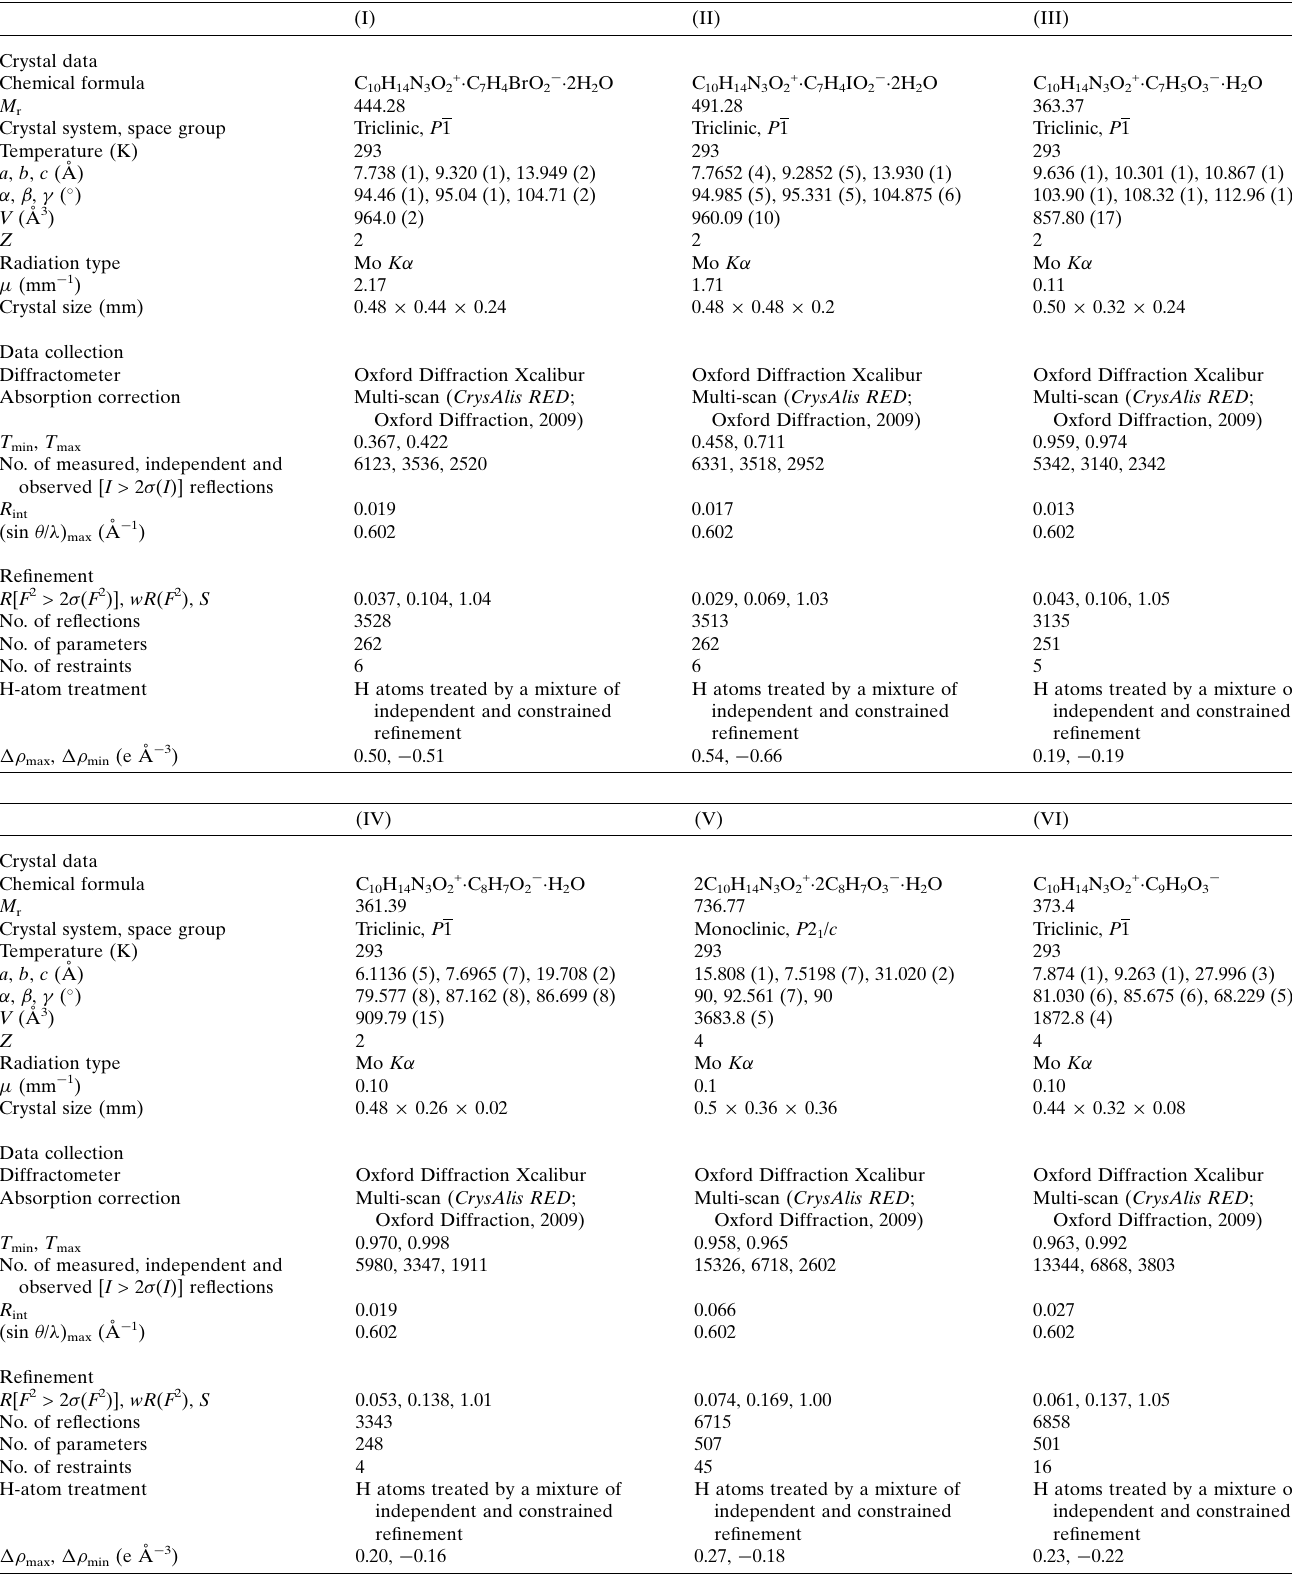
Table 7 Experimental